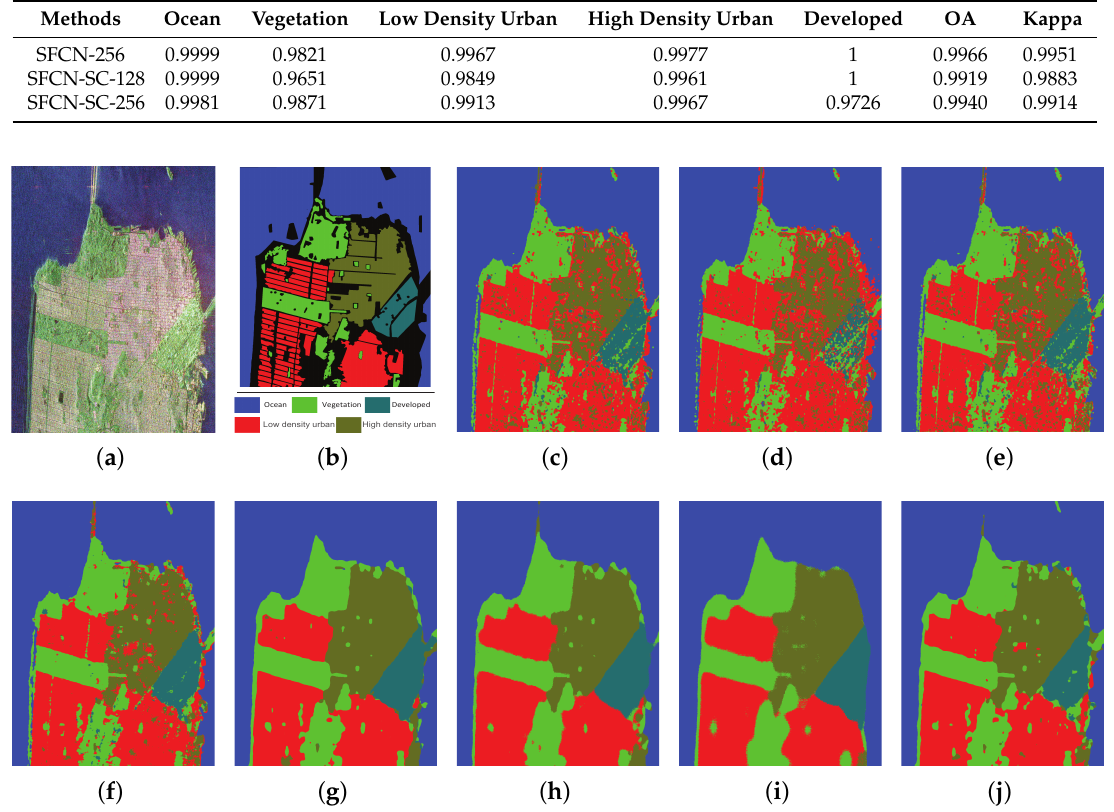
Figure 7. Classification results of San Francisco with different methods. ( a ) PauliRGB image; ( b ) ground truth map; ( c ) SVM; ( d ) SRC; ( e ) SAE; ( f ) CNN; ( g ) SFCN-128; ( h ) SFCN-256; ( i ) SFCN-SC-128; ( j )